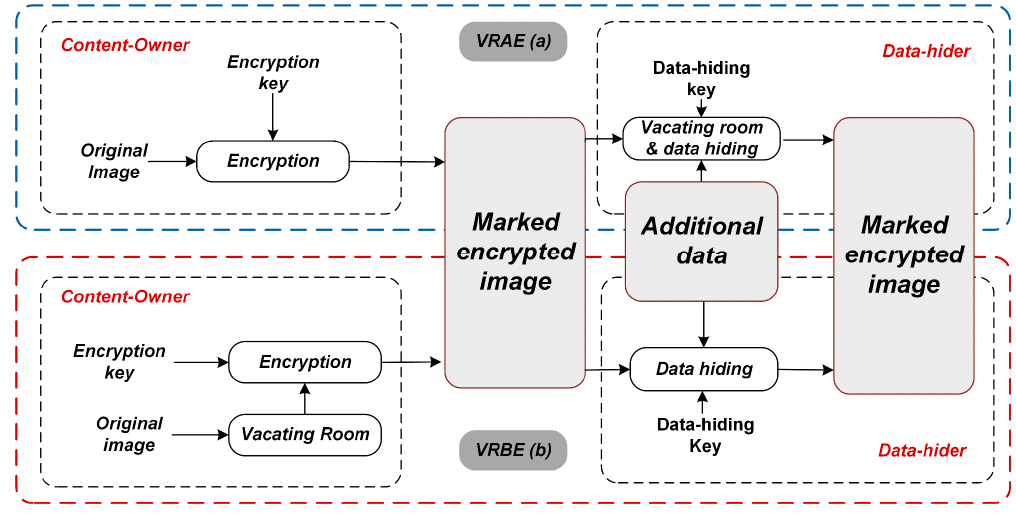
Figure 2. ( a ) Vacating room after encryption (VRAE); and ( b ) vacating room before encryption